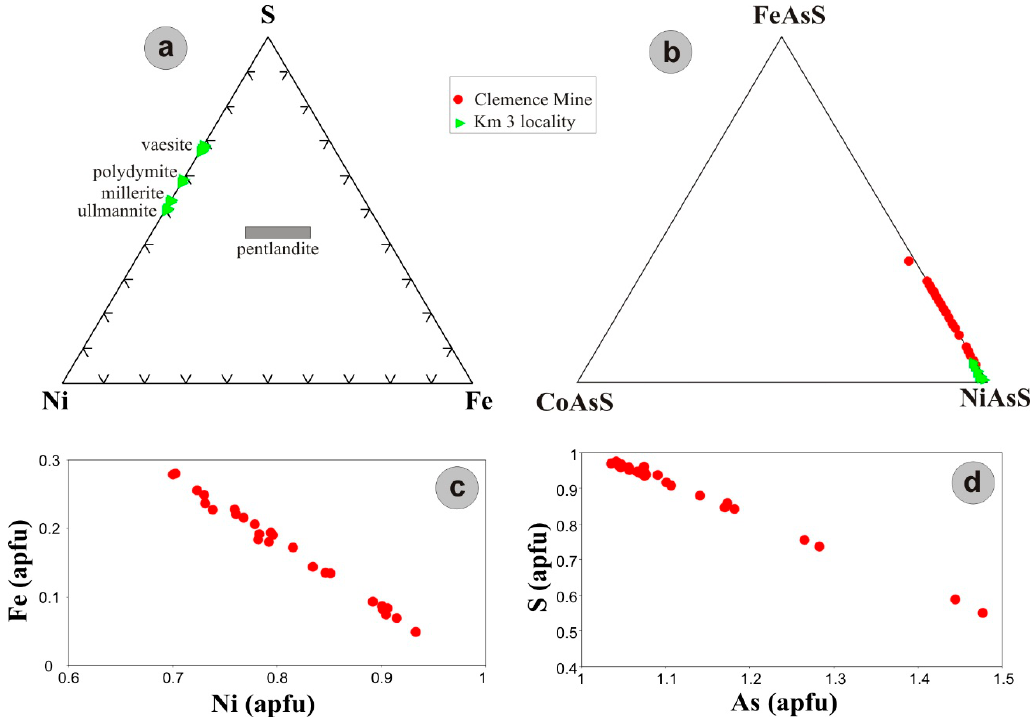
Figure 7. Chemical variation of Ni sulfides/sulfarsenides from Lavrion: ( a , b ) Ternary plots in terms of Ni, Fe, S and Ni, Fe, Co, respectively; ( c , d ) Fe vs Ni and As vs S plots.